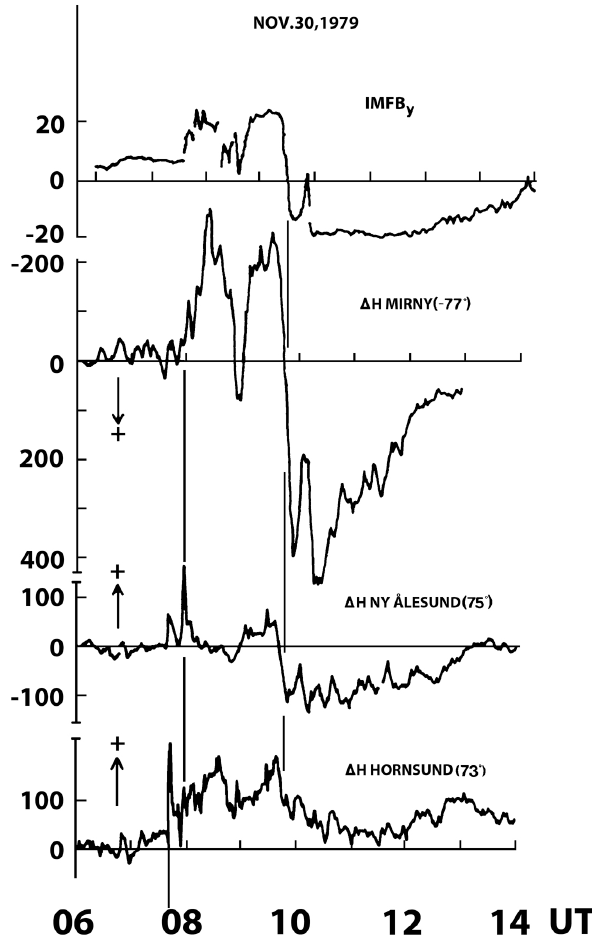
Fig. 2. Panels from top to bottom shows the magnetic field B y (east-west component) trace obtained from spacecraft ISEE 1, and H-component of the ground magnetic deflections from sta- tions in Antarctica (Mirny; − 77 ◦ MLAT) and the Arctic stations Ny ˚Alesund (75 ◦ MLAT) and Hornsund (74 ◦ MLAT) on Svalbard. The ISEE trace is displaced forward by approx.